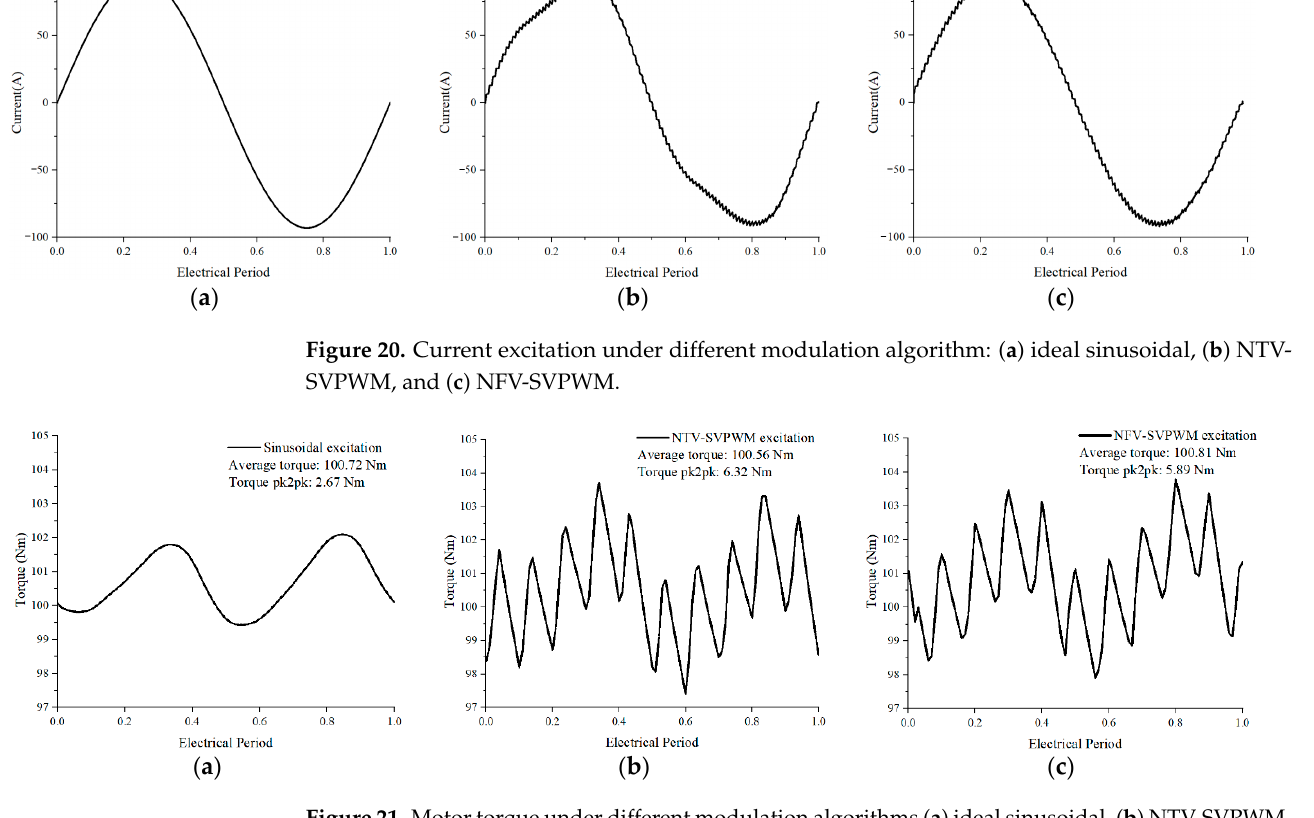
Figure 19. MPTA control of the five-phase PMSM block diagram.